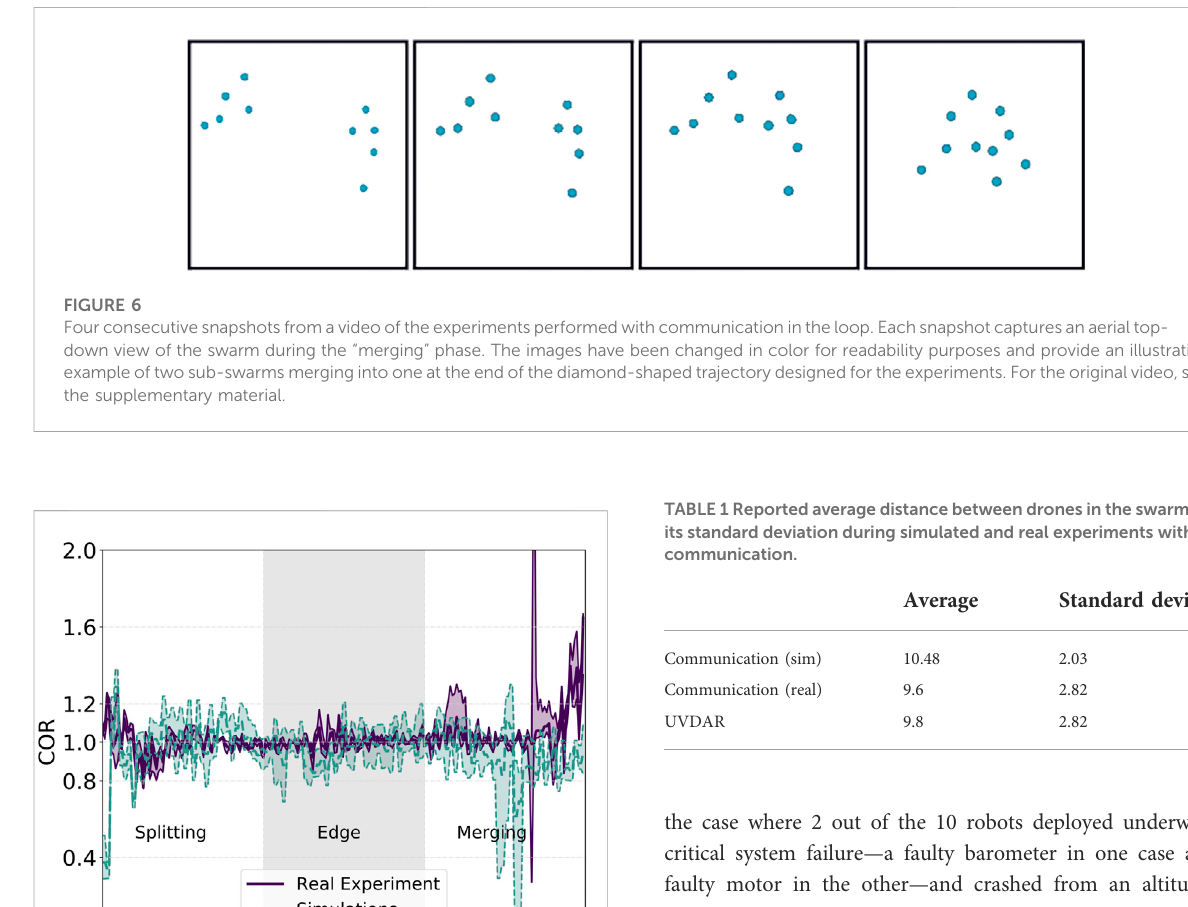
FIGURE 7 Reported COR metric for the simulated and real experiments with communication. Close to 1 y-values show better COR performance. The metric is not computed for the whole experiments but only from the start until the group reaches the merging phase at roughly 400 m from the starting position. The last straight returning phase after the merging does not provide additional information and is left out for the sake of clarity.